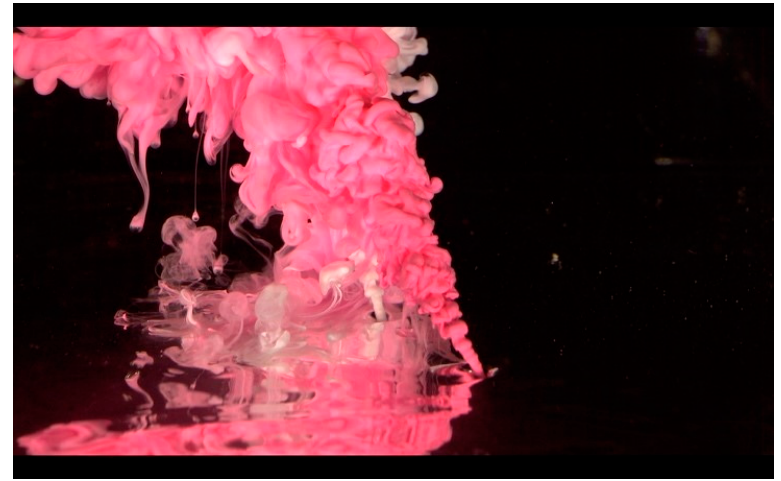
Figure 12. Injection of color paints into fluid.